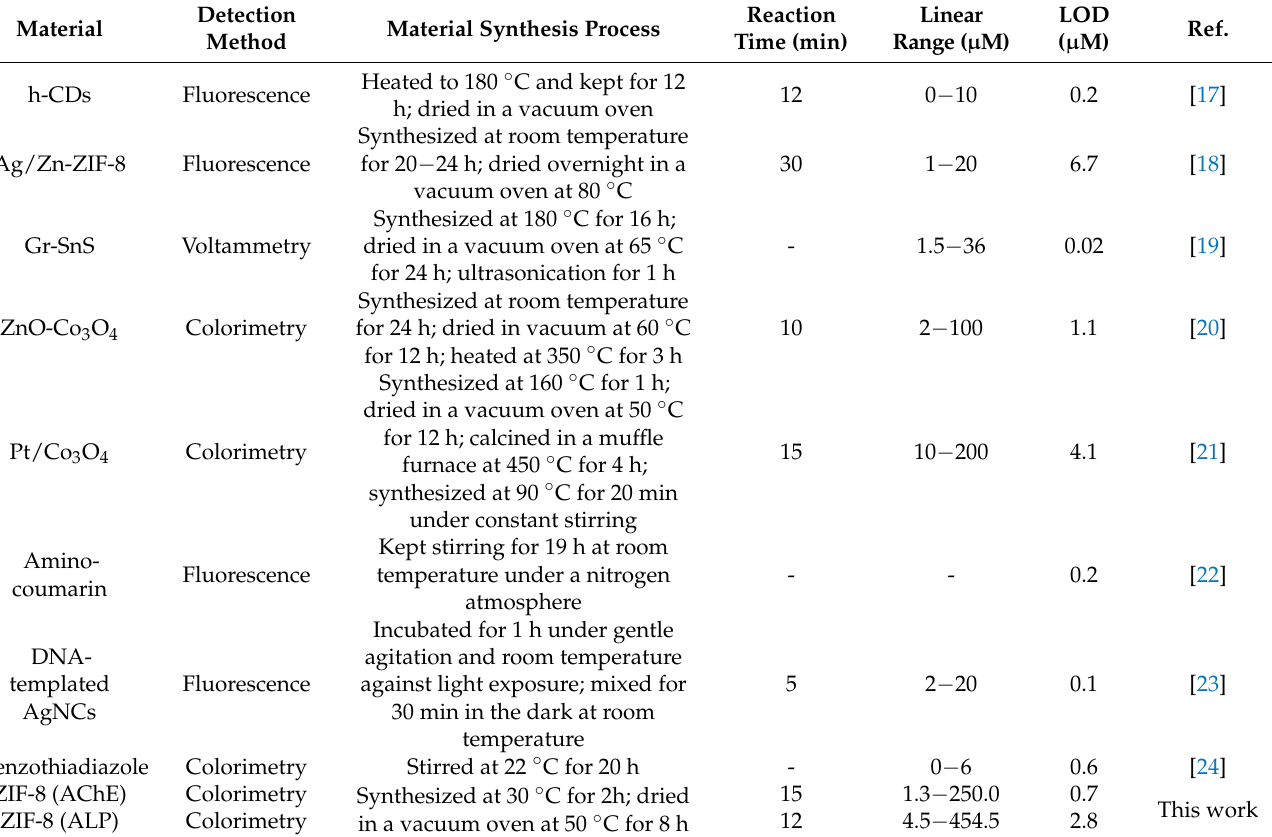
Table 1. Comparisons of the previously reported methods and present work for the detection of Cu 2+